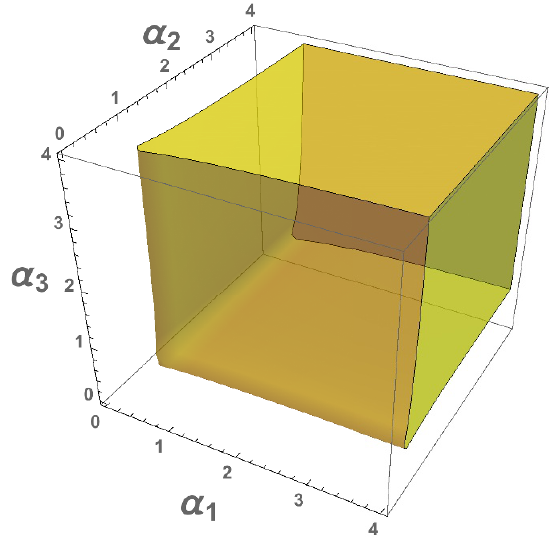
p p p 3 ; 1 = 3 ; 1 = 3).